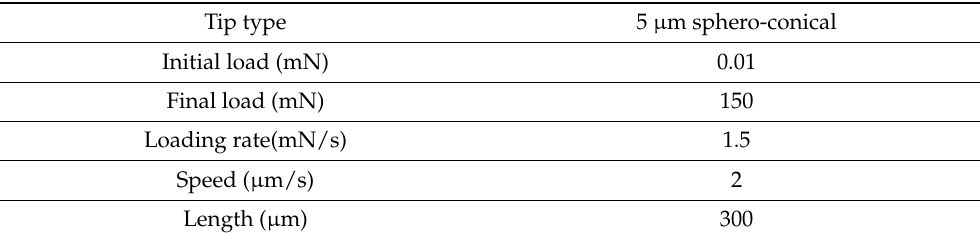
Table 2. Experimental setup of the nanoscratch test.